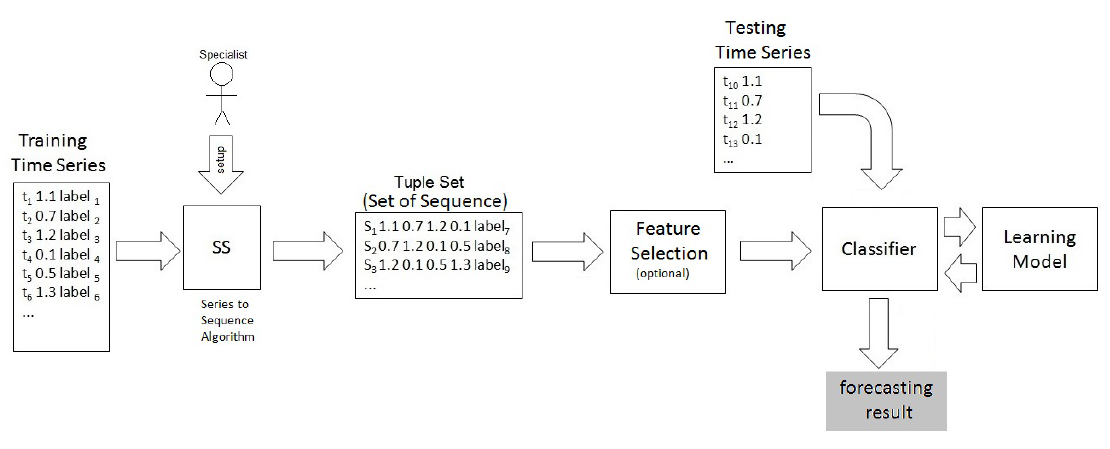
Figure 1. SeMiner: Method